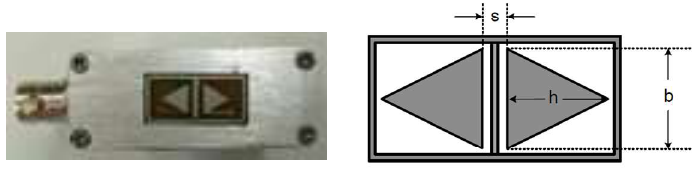
Figure 2. CI sensor with triangular electrodes.